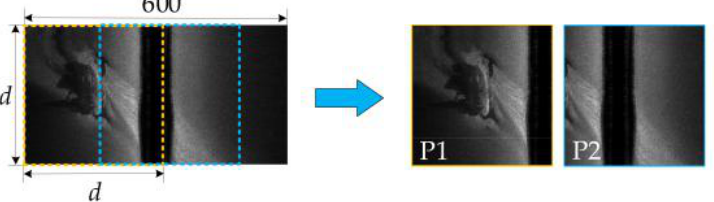
Figure 5. The schematic diagram of patches generation by sliding operation in a sampling. The orange and blue dashed boxes denote two adjacent patches, P1 and P2, with the size of d × d